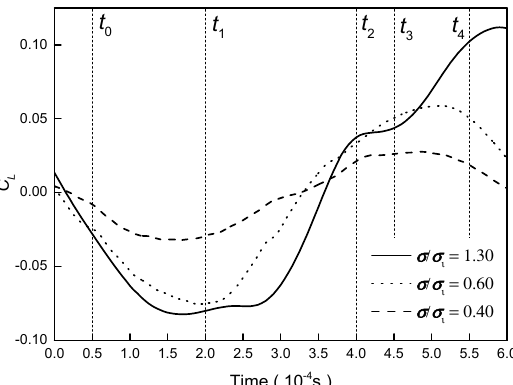
Figure 8. Comparison of lift coefficient, C L , evolutions during less than one shedding period at different cavitation conditions.